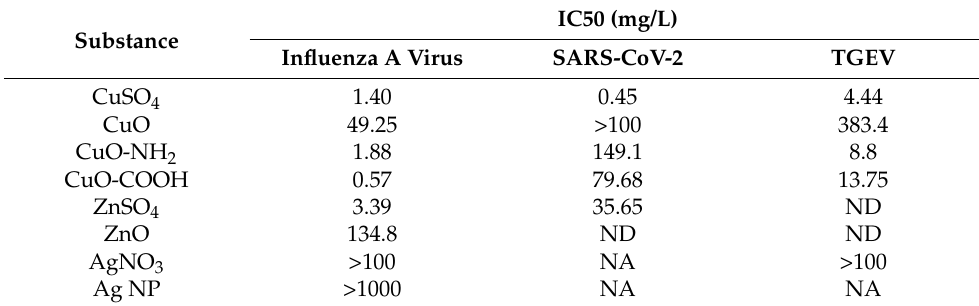
Table 1. Antiviral efficacy of metal salts and metal nanoparticles against influenza A virus, SARS-CoV-2, and TGEV in water suspensions. IC50 (mg/L) Substance Influenza A Virus SARS-CoV-2 TGEV CuSO 4